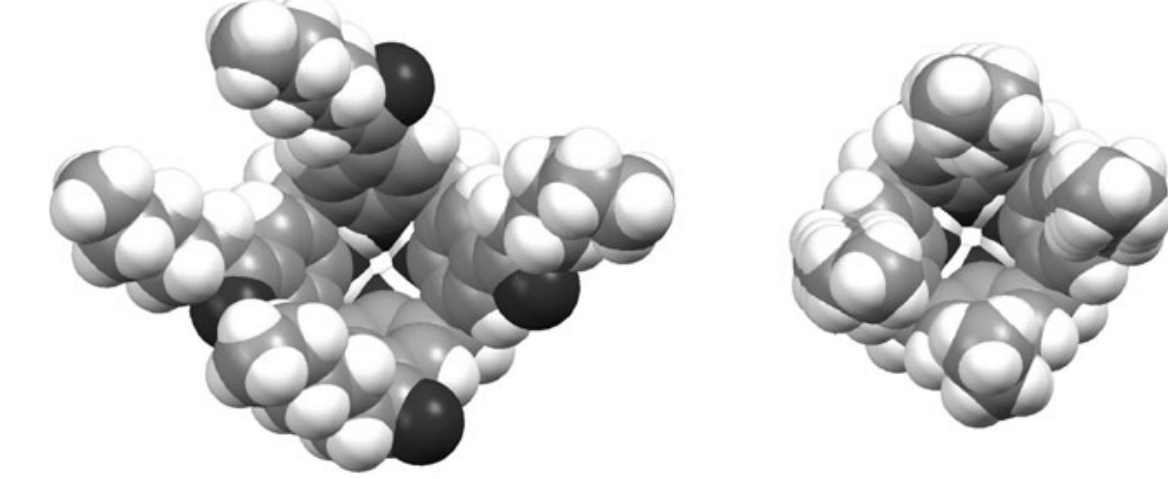
Figure 10. Top view to the cavity of para -hexanoylcalix[4]arene 2a ( left ) and para -hexylcalix[4]arene ( right )